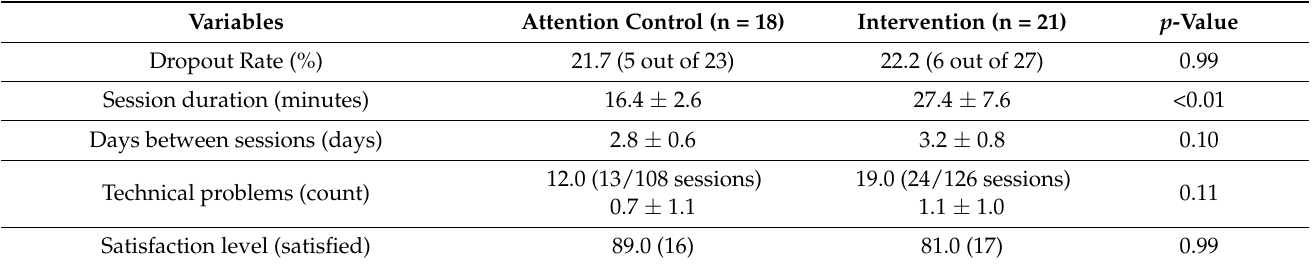
Table 1. Feasibility outcomes. Data compared using student’s t -test or Mann–Whitney test. Data reported as mean ± SD or frequency